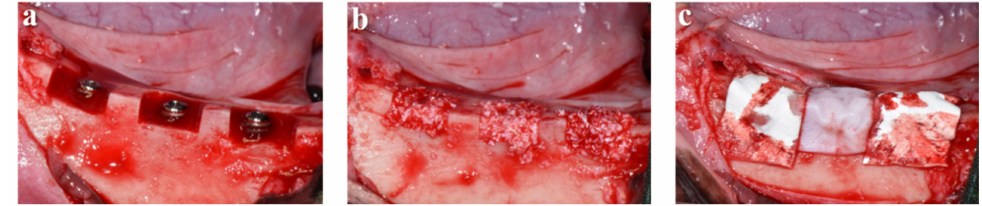
Figure 1. Surgical procedure to perform guided bone regeneration (GBR) in beagle dogs. ( a ) Implants placed in bone defect areas; ( b ) bone grafting; ( c ) membrane placement after bone